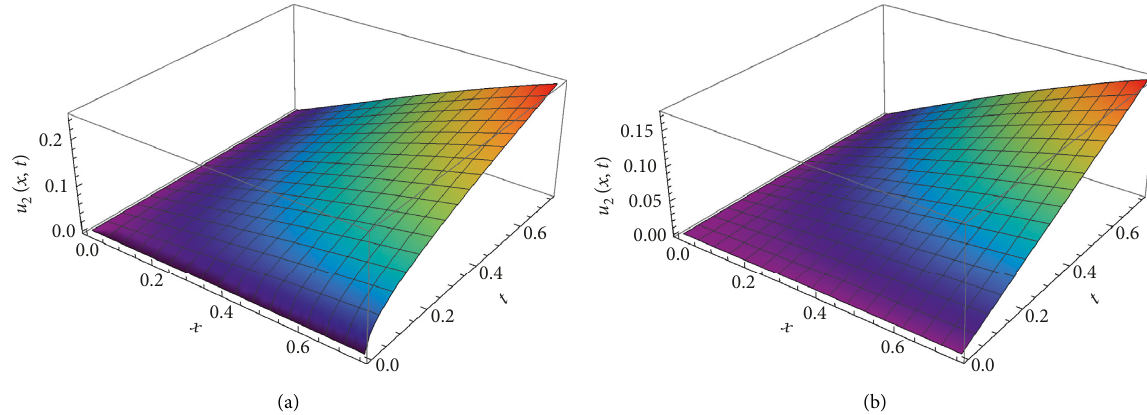
Figure 6: The graphs of second-order iterative solution u ( x, t ) for (30) through various points x, t at α � 0 . 5 , 1, respectively. (a) The graph 2 ( x,t ) for (30) through various values of x, t at α � 0 . 5. (b) The graph of second-order iterative solution of second-order iterative solution u 2 ( x, t ) for (30) through various values of x, t at α � u 2